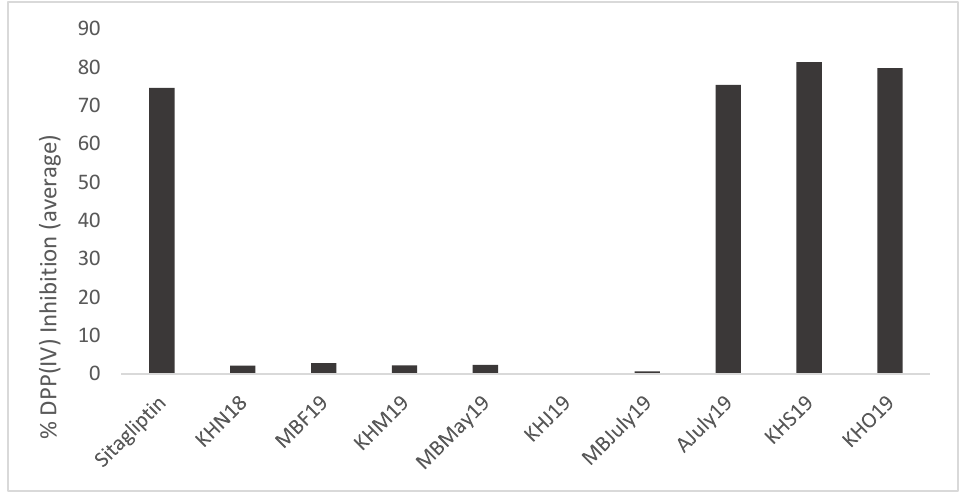
Figure 7. DPP (IV) inhibition (%) by mussel Protamex ® hydrolysates. Nine samples from the three sampling sites, Mulroy bay, Killary harbour and Ardgroom, collected from November 2018 to October 2019, were used for analysis at a concentration of 1 mg/mL. Analysis was performed in triplicate (n = 3). No significant difference was found between positive control Sitagliptin and samples AJuly19, KHS19, KHO19 after Dunn Bonferroni (nonparametric) post hoc analysis.